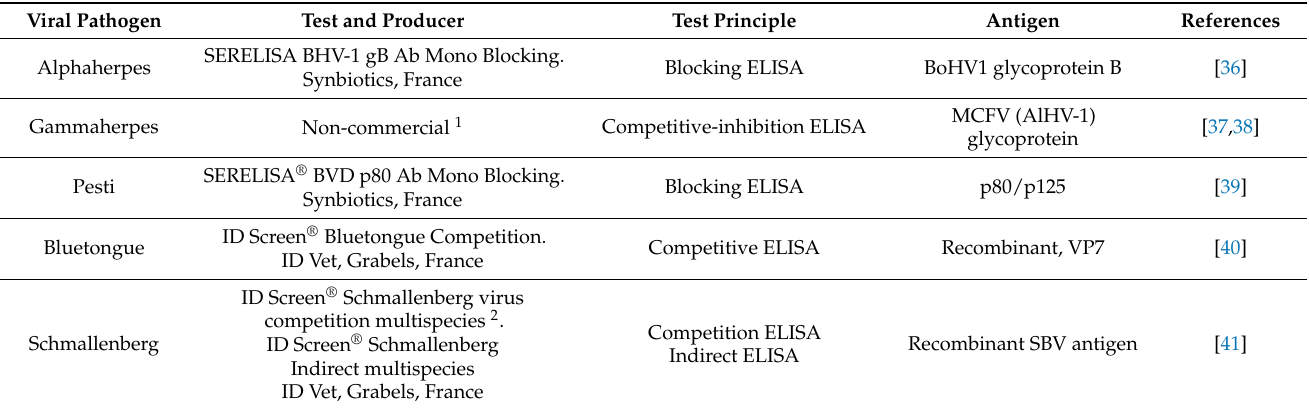
Table 2. Serological tests used to investigate wild Eurasian tundra reindeer ( Rangifer t. tarandus ) from Iceland (2017–2019) for antibodies against viral